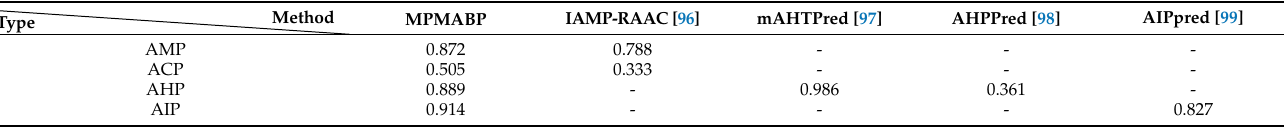
Table 4. Comparison with four existing state-of-the-art methods.